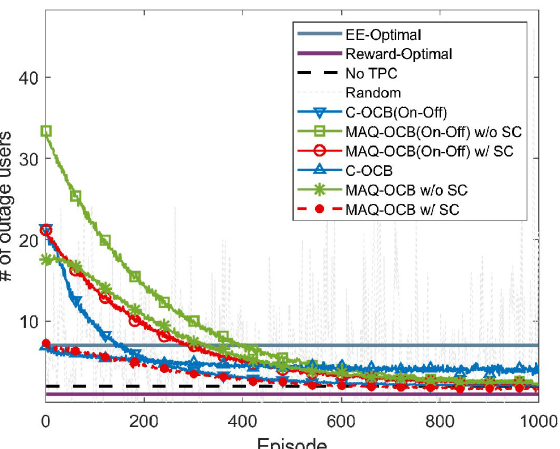
Figure 5. Number of outage users vs. episode when | U | = 60, | M | = 3, and | N | =